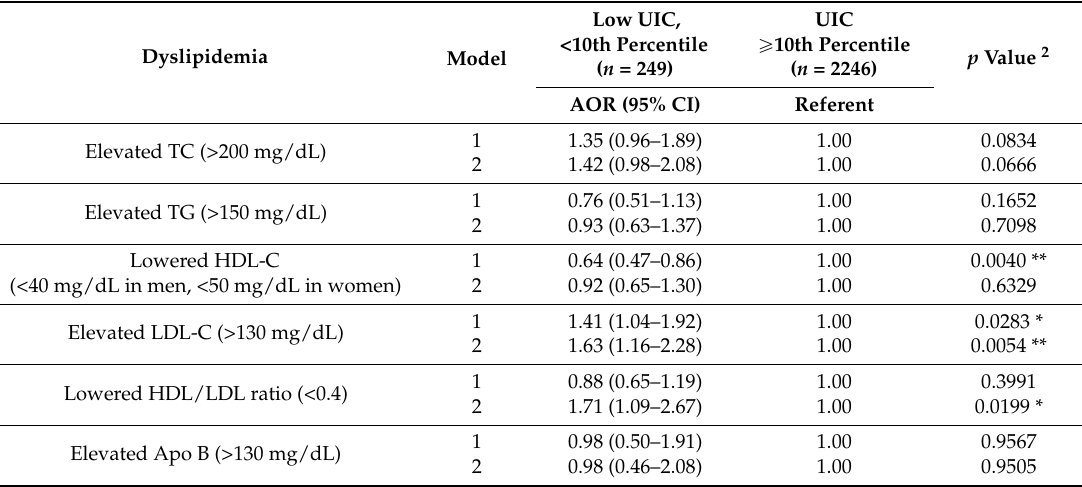
Table 4. Prevalence of dyslipidemia of adults in relation to urinary iodine concentration in US adults, NHANES 2007–2012 1